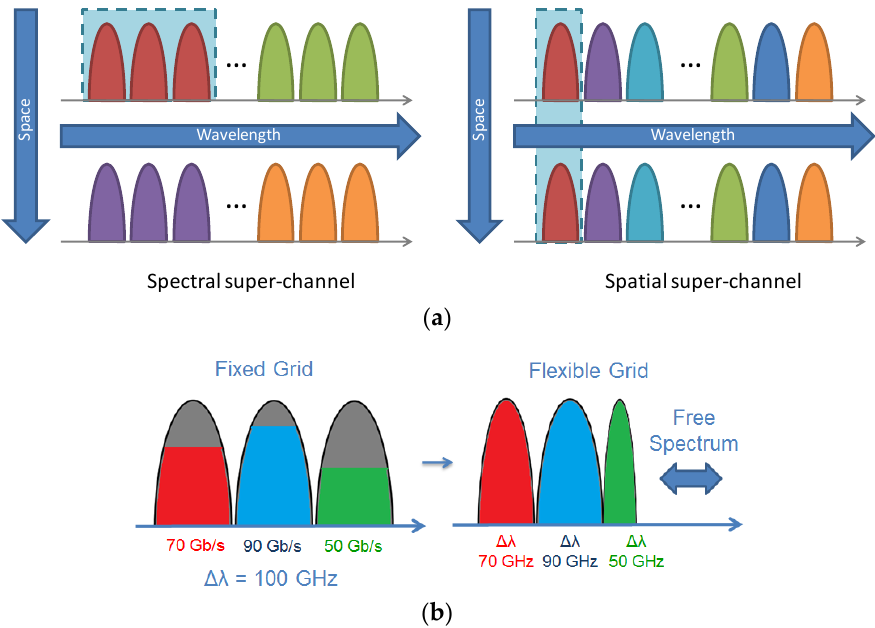
Figure 6. ( a ) Comparison of spatial and spectral super-channels. ( b ) Schematic representation of the advantages of flexible grids in terms of spectral efficiency.